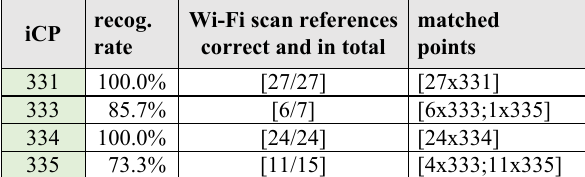
Table 2. Detailed results of the fingerprinting strategies